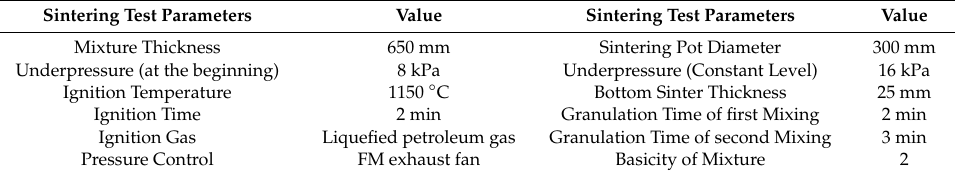
Figure 1. Flow chart of sintering pot test. Table 3. Parameters of sintering pot.